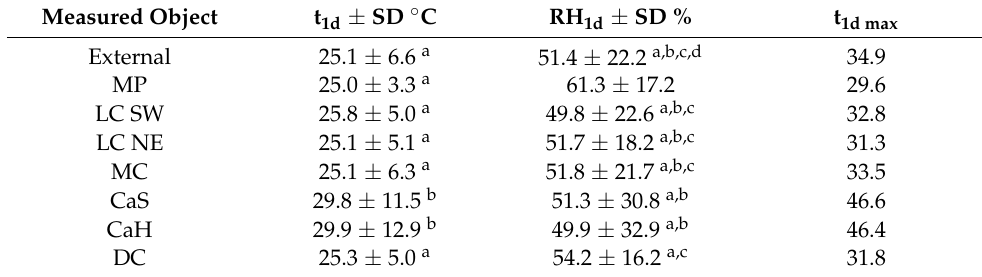
Table 2. Results of measurement and statistical comparison of parameters of thermal–humidity environment of outdoor air and thermal–humidity environment of indoor air in all investigated buildings during the hot summer day. All values in the individual columns are compared. Different superscript letters ( a,b,c,d ) are a sign of a significant difference ( ANOVA ; Tukey’s HSD test ; p ≤ 0.05) between measured values in the individual columns. Identical superscript letters for numbers in a column indicate that there is no statistically significant difference between measured values in compared objects. Measured Object External